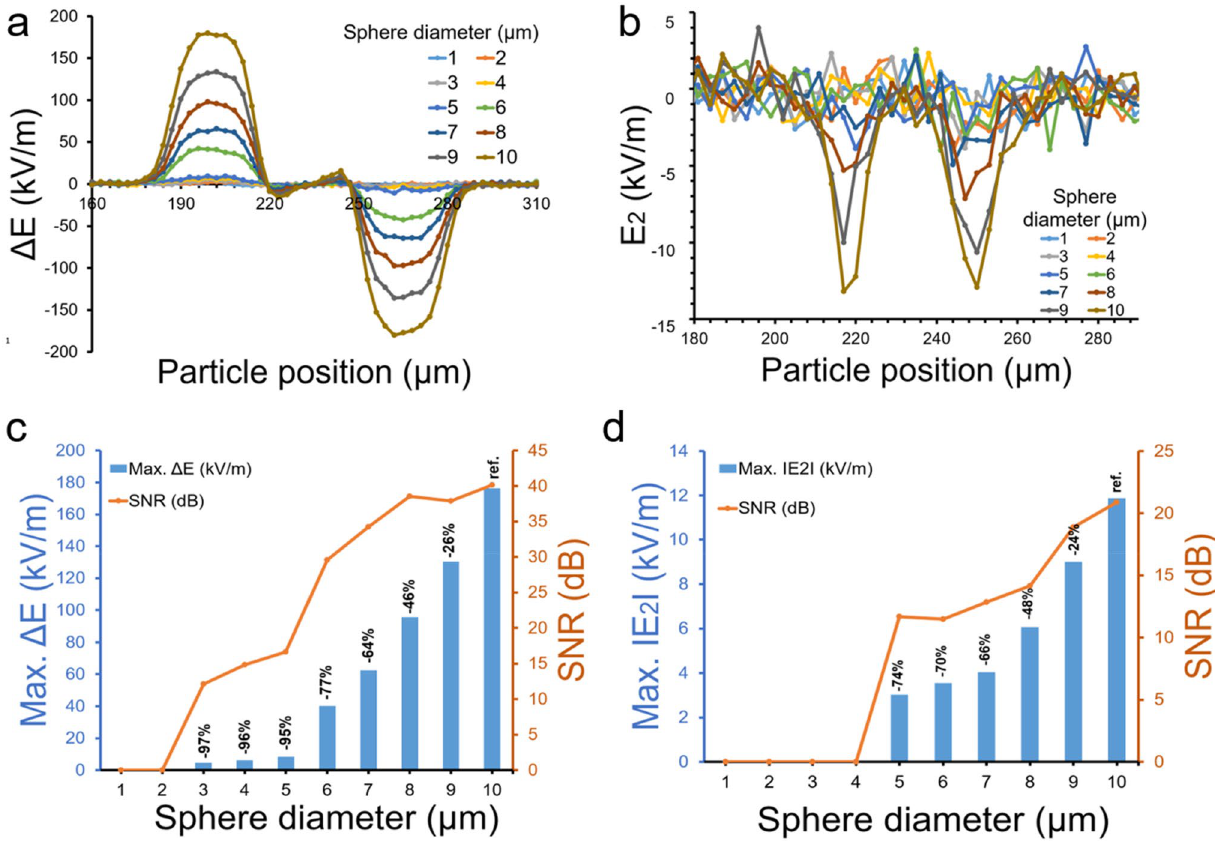
Figure 3. ( a , b ) Simulation of ΔE and E 2 signals for spherical particle versus diameter increment from 1 to 10 in µm, ( c , d ) Comparison of maximum values of ΔE and │ E 2 │ and their resctive SNR in dB for spherical particle diameter ranges from 1 to 10 µm